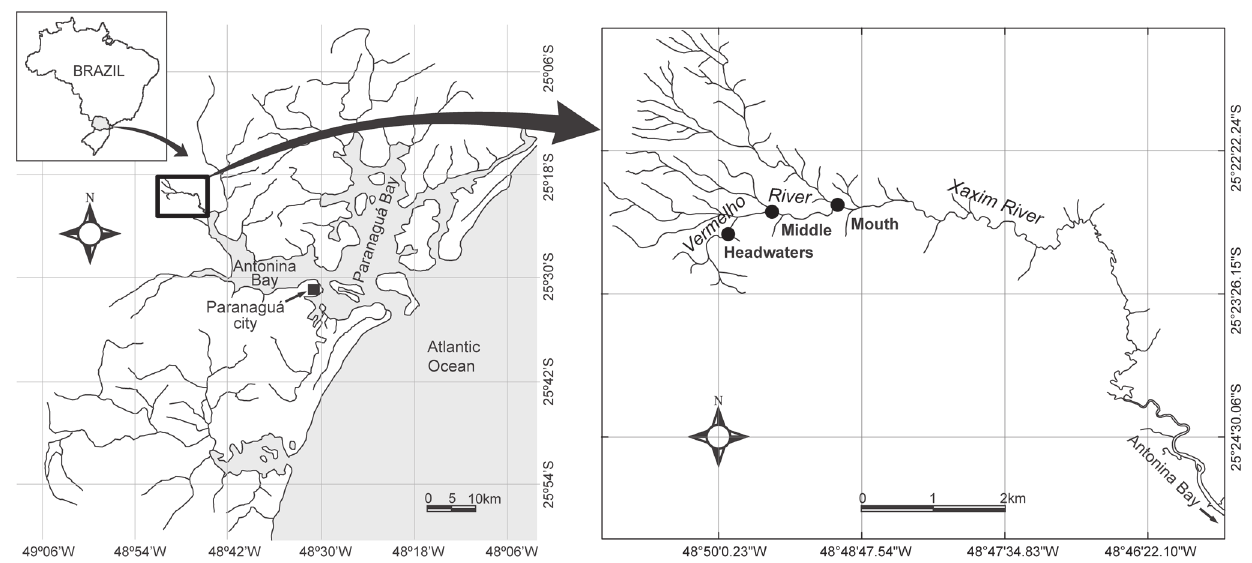
Fig. 1. Location of the Vermelho River, East Atlantic basin, Antonina, Paraná State, Brazil. Black circles indicate the sampling sections; arrow indicates the direction of